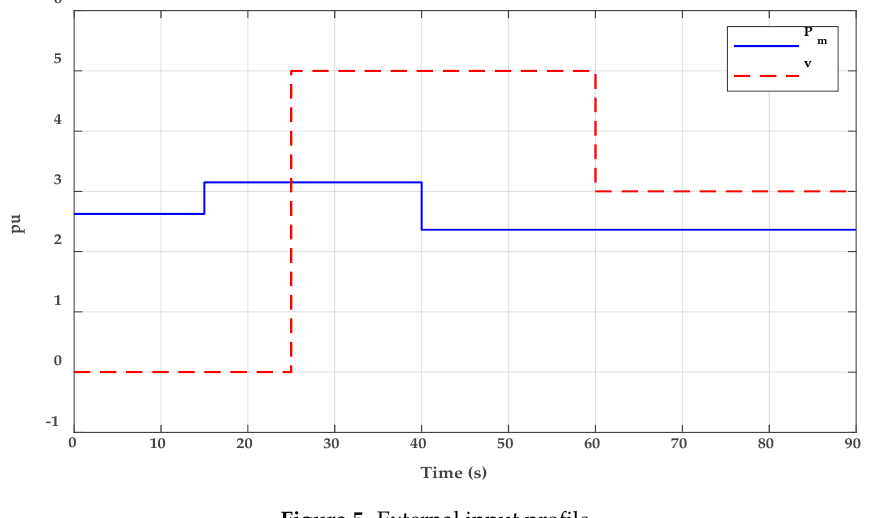
Figure 5. External input profile.